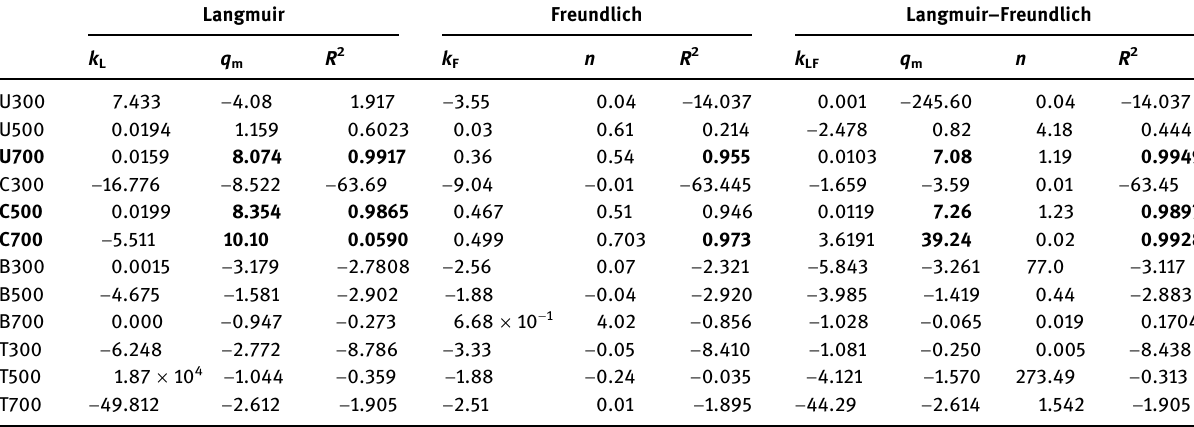
Table 4: Isothermal adsorption fi tting